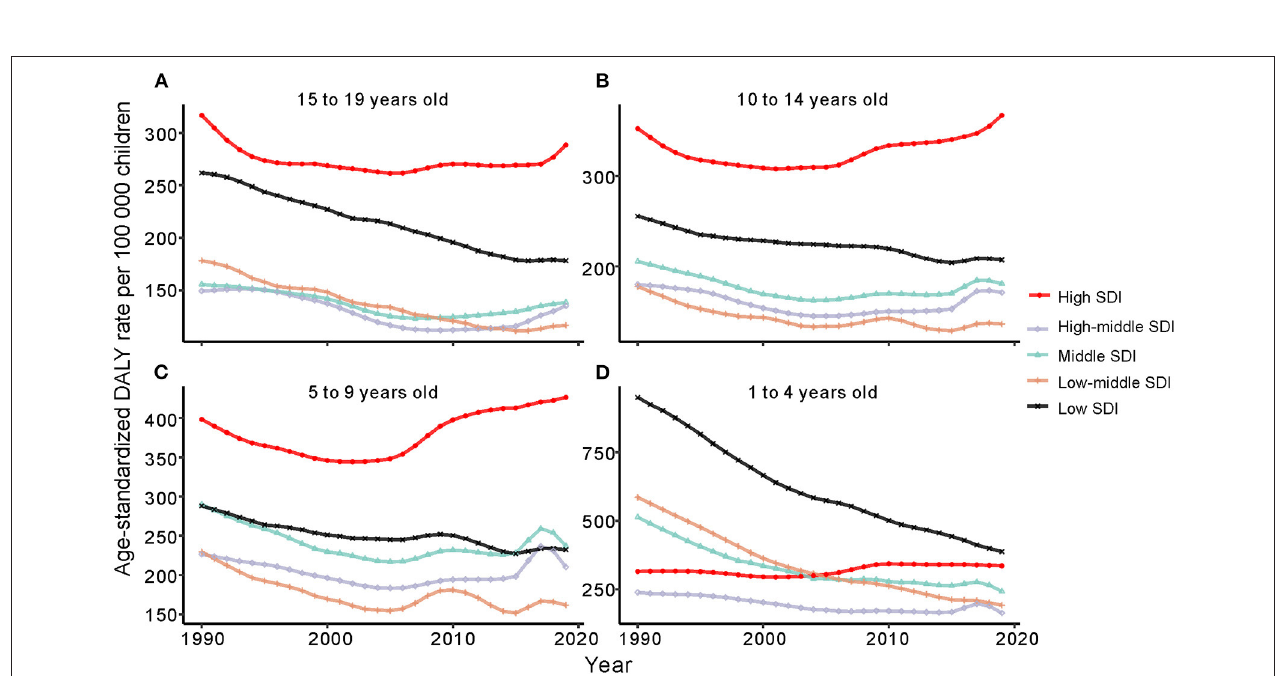
FIGURE 3 | Change trends of age-standardized DALYs due to childhood asthma by age group from 1990 to 2019. (A) Change trends of age-standardized DALYs in 15 to 19 year olds. (B) Change trends of age-standardized DALYs in 10 to 14 year olds. (C) Change trends of age-standardized DALYs in 5 to 9 year olds. (D) Change trends of age-standardized DALYs in 1 to 4 year olds. DALYs, disability adjusted life years.